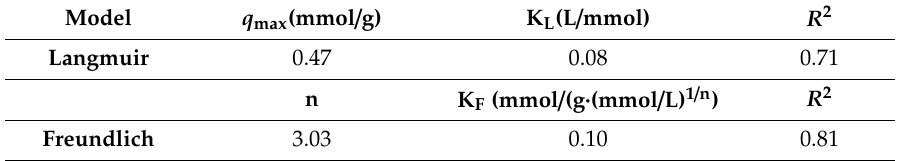
Table 3. Langmuir and Freundlich constants calculated from amines adsorption data on STx.